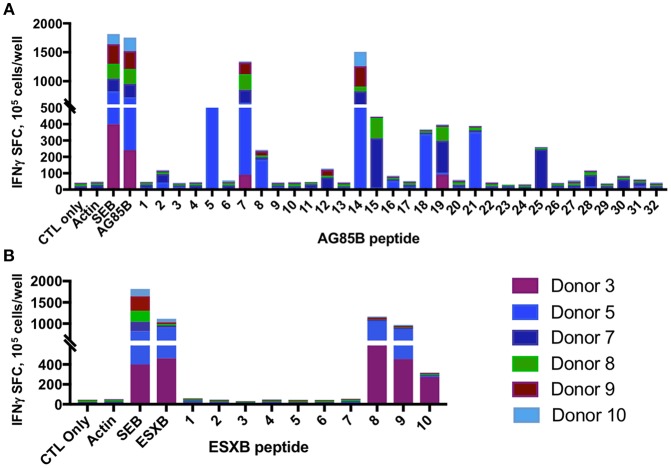
MSTs recognize multiple epitopes within AG85B and ESXB. Epitope mapping of AG85B (A) and ESXB (B) via IFN-γ ELISpot showed eight peptides from AG85B and three from ESXB recognized by MSTs from multiple healthy donors. SFC, spot forming colonies; SEB, staphylococcal enterotoxin B.